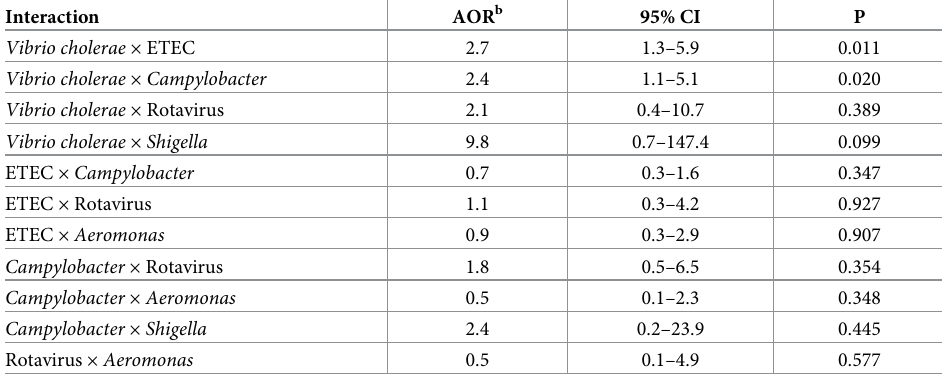
AOR, adjusted odds ratio; CI, confidence interval; ETEC, enterotoxigenic Escherichia coli ; NTS, non-typhoidal Salmonella . a Following interactions were not examined because coinfection with these combinations were absent among the cases and/or the controls: Vibrio cholerae × Aeromonas , Vibrio cholerae × NTS, ETEC × Shigella , ETEC × NTS, Campylobacter × NTS, Rotavirus × Shigella , Rotavirus × NTS, Aeromonas × Shigella , Aeromonas × NTS, Shigella × NTS b Each dual pathogen interaction model is adjusted for the main effect of the stated two pathogens, age, place of residence relative to the location of Dhaka hospital, whether the patient (or their family members) borrowed money or relied on aid to pay for the transport to the hospital, source of drinking water, frequency of collection of water for cooking and washing, and whether the patients or their parents disposed of household solid waste directly outside the